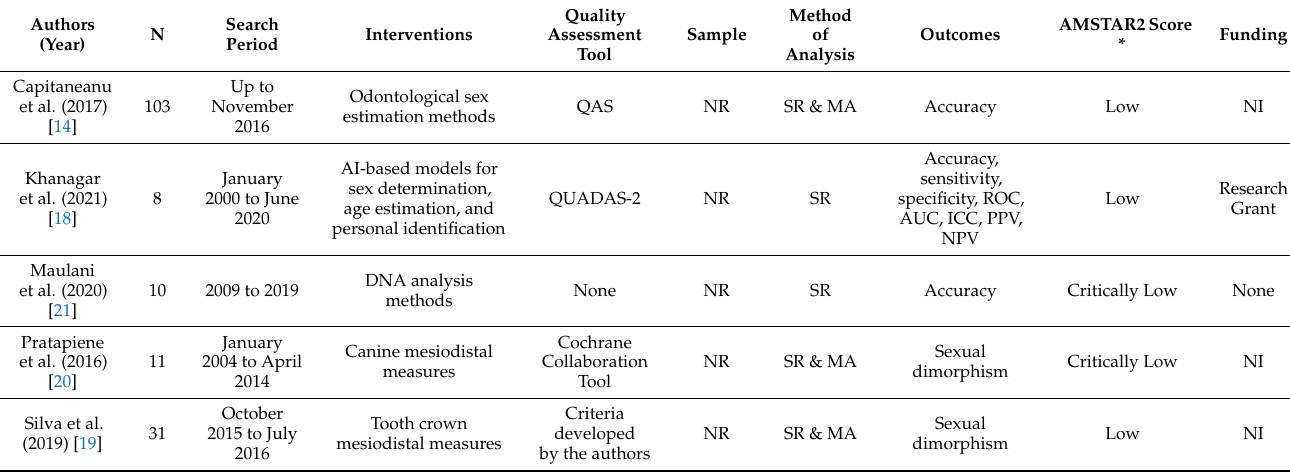
Table 1. Characteristics of included SRs.